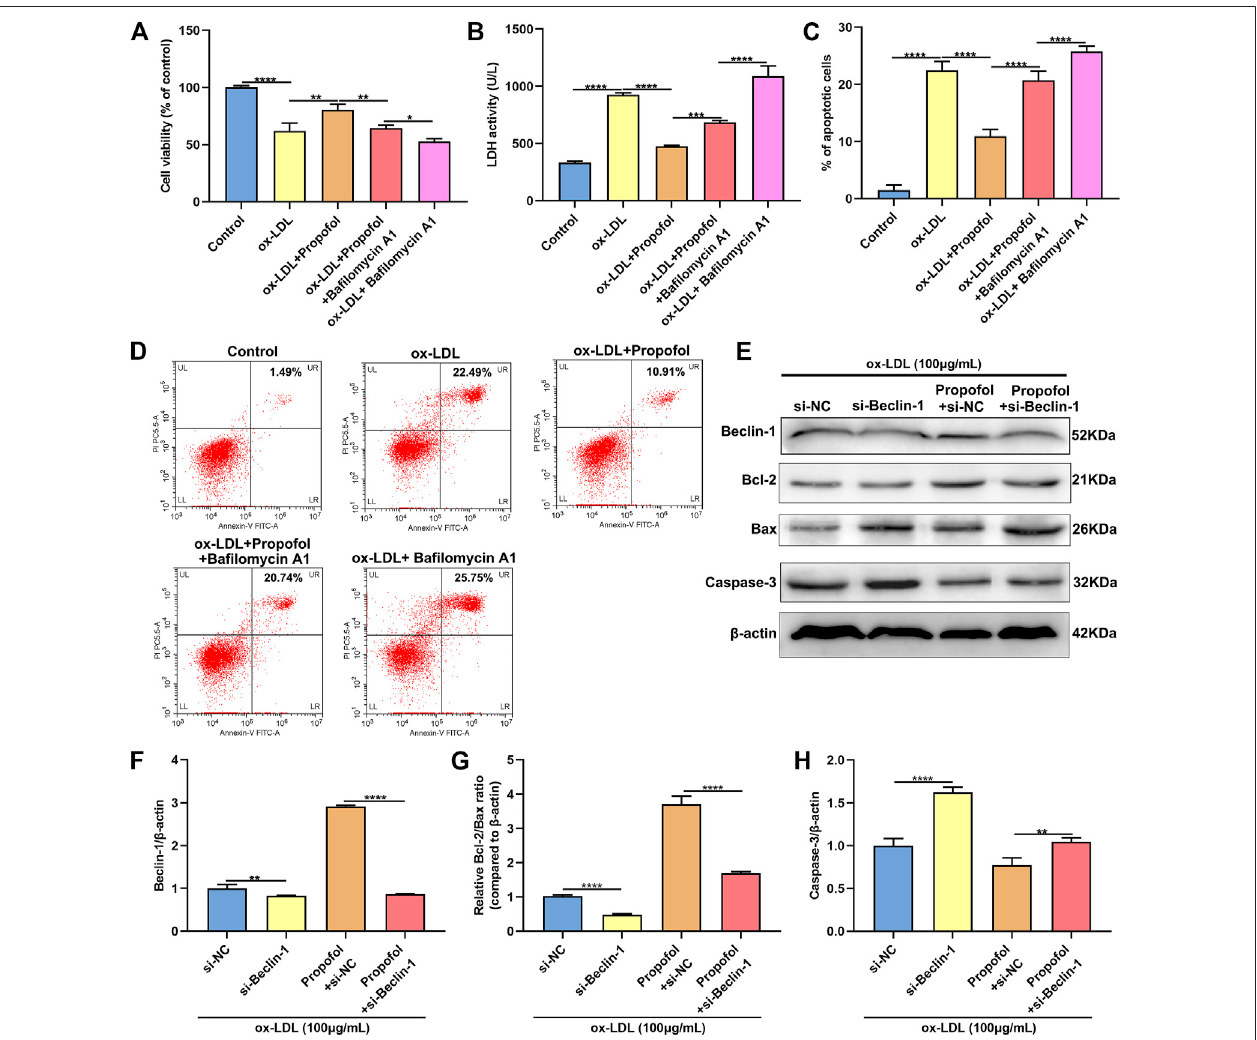
FIGURE 4 | Propofol ameliorates ox-LDL-induced damage of HUVECs by enhancing autophagy. (A) The cell viability of 100 ° μ g/ml ox-LDL-induced HUVECs treated with 100 ° μ M Propofol and / or 100 ° μ M Ba fi lomycin A1. (B) LDH release levels were examined in 100 ° μ g/mL ox-LDL-induced HUVECs treated with 100 ° μ M Propofol and / or 100 ° μ M Ba fi lomycin A1. (C, D) Flow cytometry assay was presented to assess the apoptotic levels of 100 ° μ g/mL ox-LDL-induced HUVECs treated with 100 ° μ M Propofol and / or 100 ° μ M Ba fi lomycin A1. (E) Representative images of western blot for Beclin-1, Bcl-2, Bax and Caspase-3 in 100 ° μ g/ml ox-LDL- exposed HUVECs treated with si-Beclin-1 and /or 100 ° μ M Propofol. (F) Beclin-1, (G) Bcl-2/Bax ratio and (H) Caspase-3 protein levels were quanti fi ed according to the western blot results. * p < 0.05; ** p < 0.01; *** p < 0.001 and **** p <